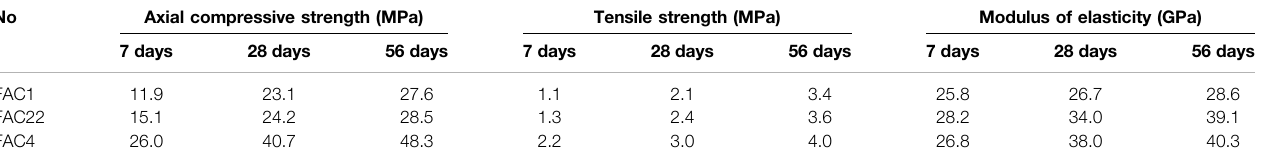
TABLE 7 | Basic mechanical properties of FAC at different curing ages. No Axial compressive strength (MPa) Tensile strength